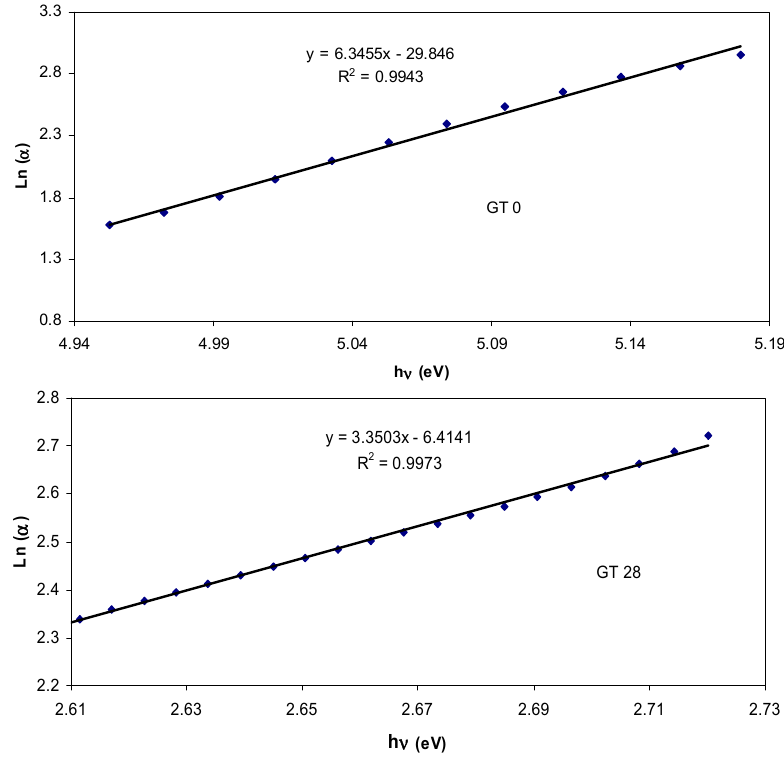
Figure 12. Urbach plot for pure PMMA (GT 0) and PMMA doped (GT 28) samples.